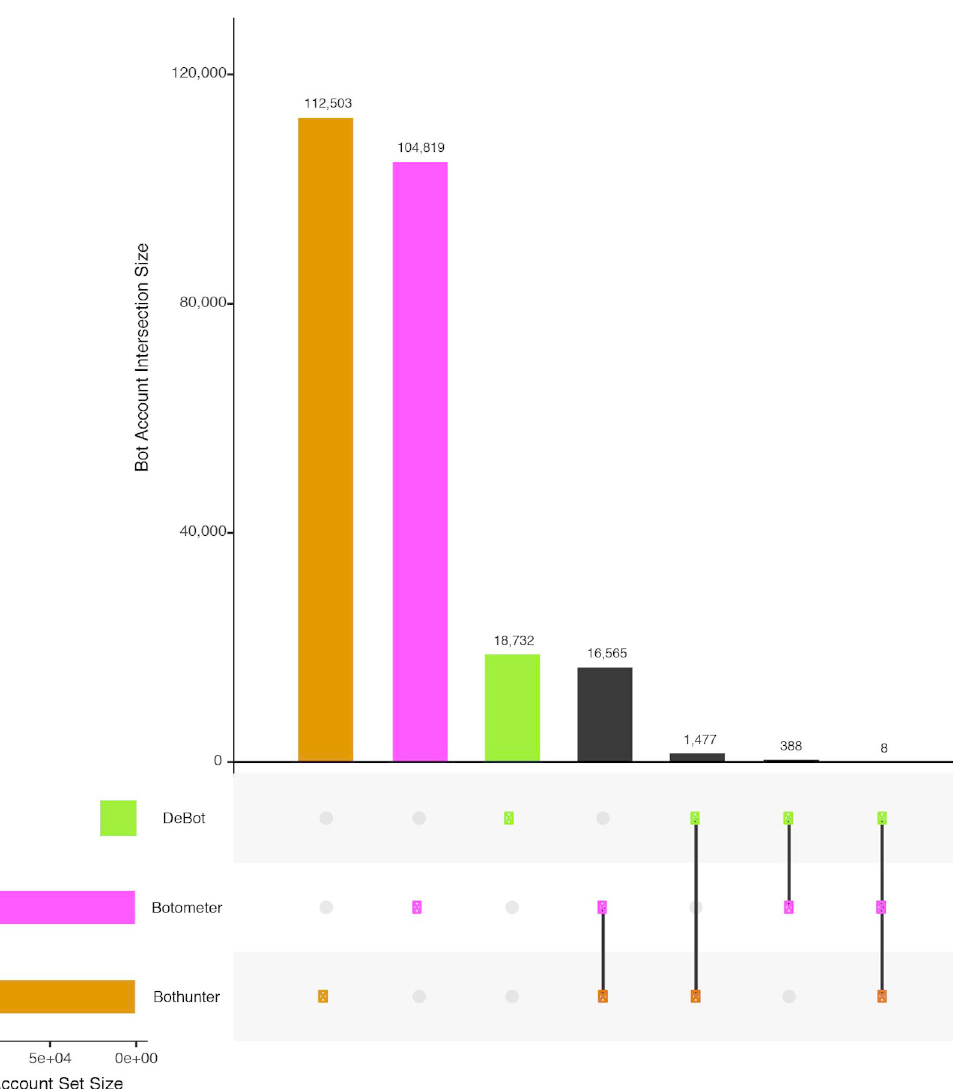
Fig 7. Bot detection coverage analysis for bots detected within the 2018 U.S. midterm election Twitter conversation using the Botometer, Bot-hunter and DeBot bot detection platforms. This figure is based on the UpSet intersection of sets visualization paradigm introduced by Lex et al.